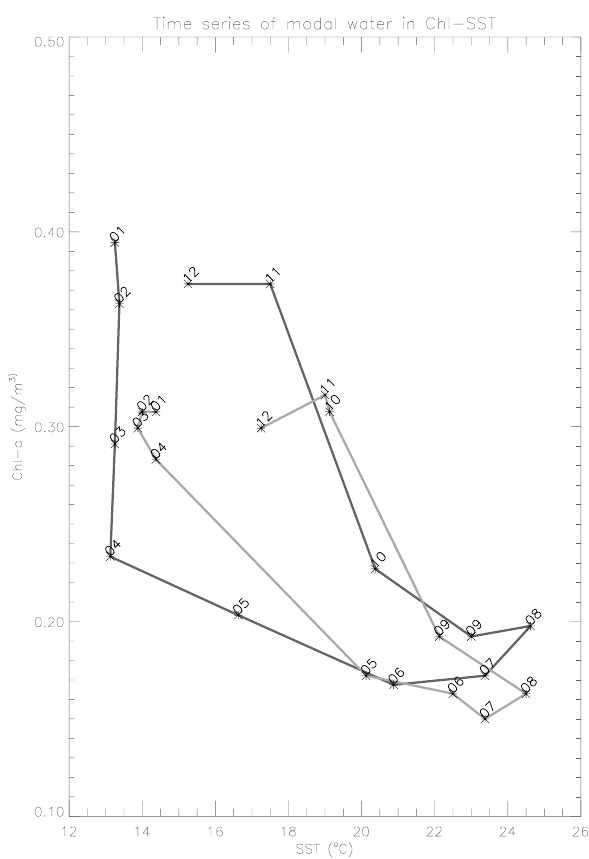
Fig. 5. Modal water time series. This plot illustrates the seasonal and interannual progression of the MW in the Chl-SST domain. It is obtained by connecting the maxima (in frequency) of each Chl- SST monthly histogram. The numeric labels, in the format YYMM indicate year and month from which they were obtained. The darker (lighter) line is for the year 1999 (2000). Wintertime warmer SST and lower Chl are observed in 1999 relative to